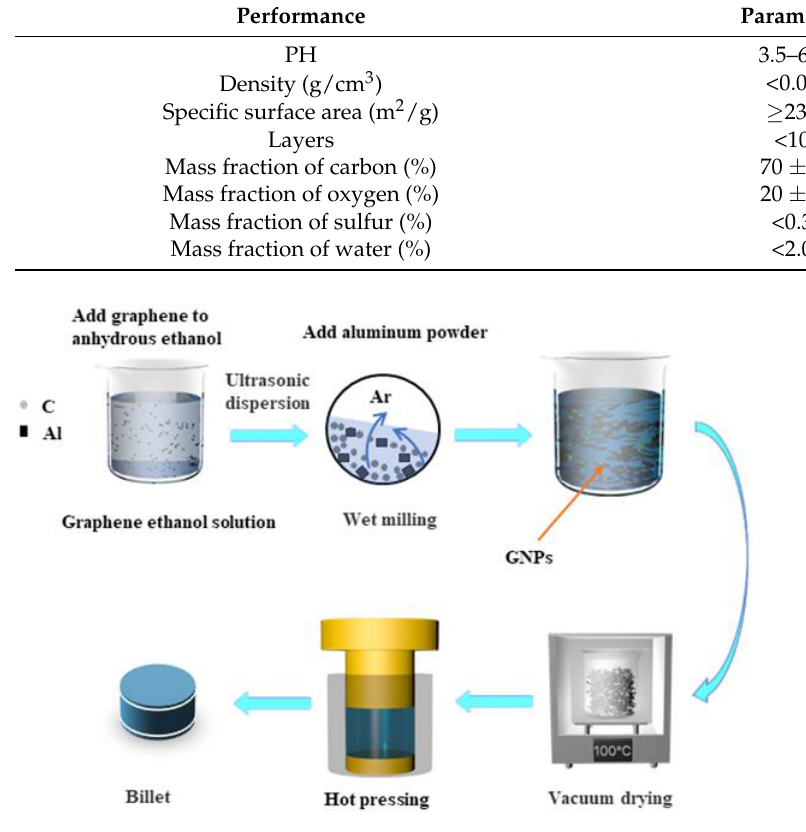
Figure 2. Powder metallurgy